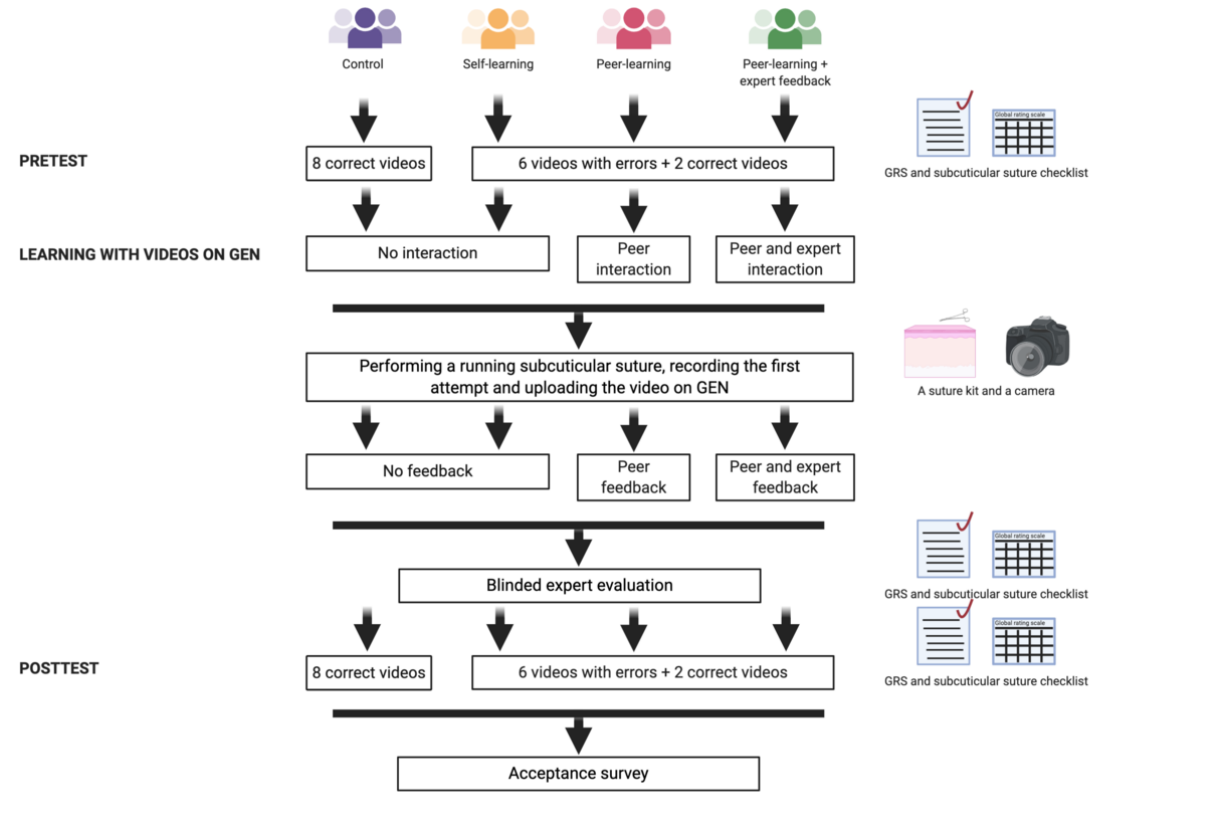
Figure 1. Study workflow. GEN: Gamified Educational Network; GRS: Global Rating